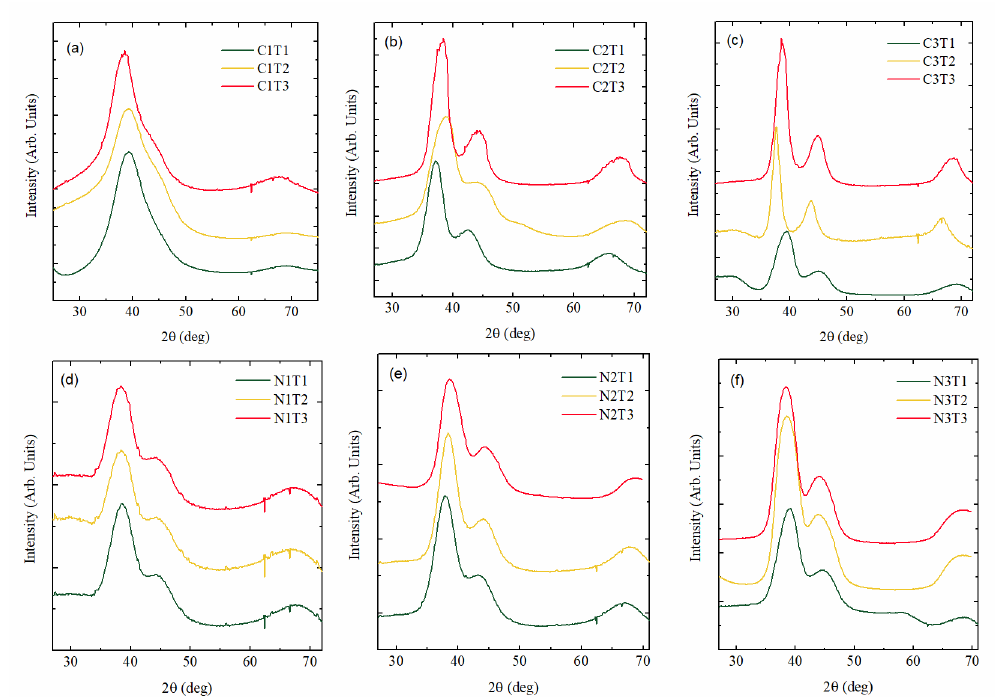
Figure 3. GIWAXS (grazing incidence wide angle X ray scattering) measurements of the Au NPs formed in ( a – c ) SiC and ( d – f ) Si